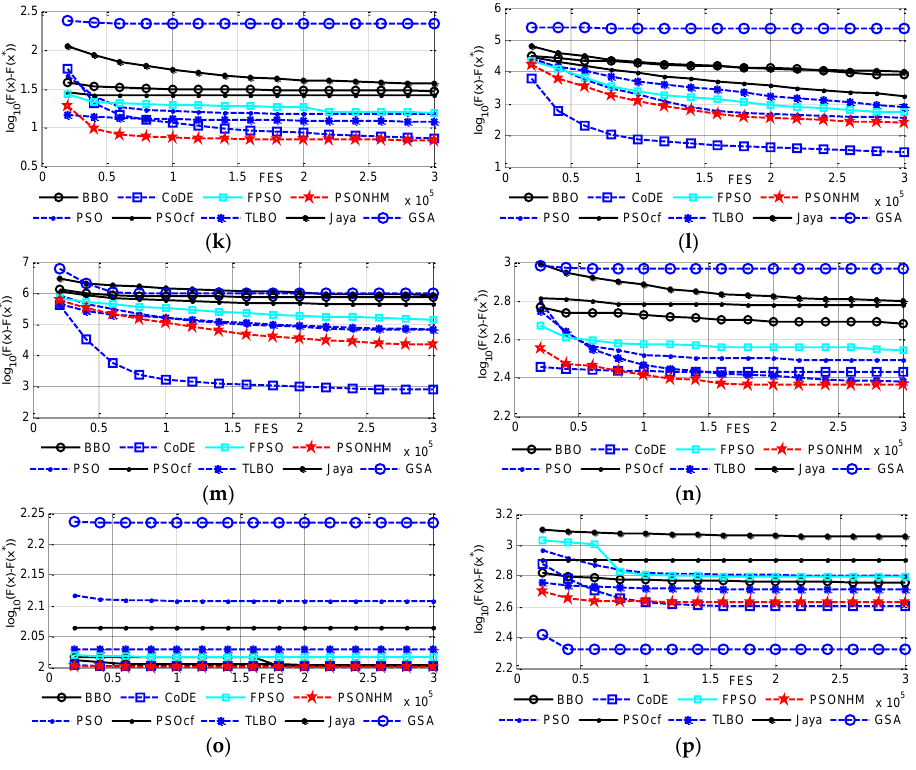
Figure 3. Evolution of the mean function error values derived from PSO, PSOcf, TLBO, Jaya, GSA, BBO, CoDE, FPSO and PSONHM versus the number of FES on sixteen test problems with D = 30. ( a ) f 2 ; ( b ) f 3 ; ( c ) f 5 ; ( d ) f 6 ; ( e ) f 7 ; ( f ) f 9 ; ( g ) f 12 ; ( h ) f 13 ; ( i ) f 15 ; ( j ) f 17 ; ( k ) f 19 ; ( l ) f 20 ; ( m ) f 21 ; ( n ) f 22 ; ( o ) f 26 ; ( p ) f 27 . Table 6. Comparison of PSONHM with PSO, PSOcf, TLBO, Jaya, GSA, BBO, CoDE and FPSO on the CEC2014 benchmarks (D = 30 dimensions).